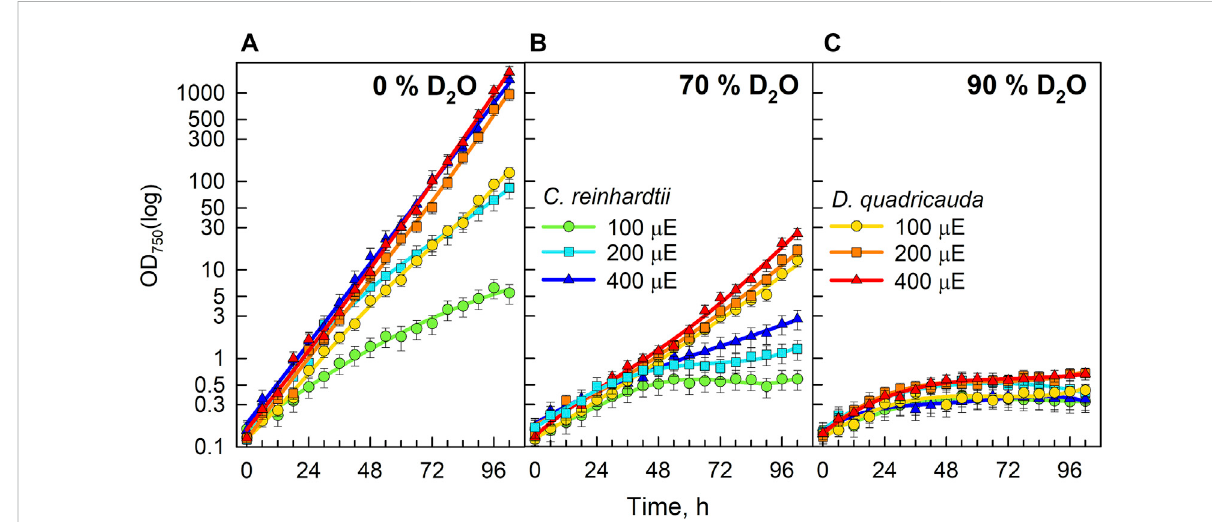
FIGURE 2 Growth of algal cultures measured as optical density at 750 nm (OD 750 ) in control culture in 0% D 2 O (A) , 70% D 2 O (B) or 90% D 2 O (C) at three light intensities 100, 200, and 400 μ mol m − 2 s − 1 extrapolated from semi-batch cultivation mode. Light intensities are referred to in μ E (instead of μ mol photons · m − 2 · s − 1 ), in order to fi t the legends. Note logarithmic scale on Y axis. Although the cultures were regularly diluted to ensure a constant light supply (semi-batch cultivation), the values obtained were recalculated using individual dilution factors. Therefore, the graphs represent a projection of growth in semi-batch cultivation mode to continuous growth. In this way, the graphs are easier to read and